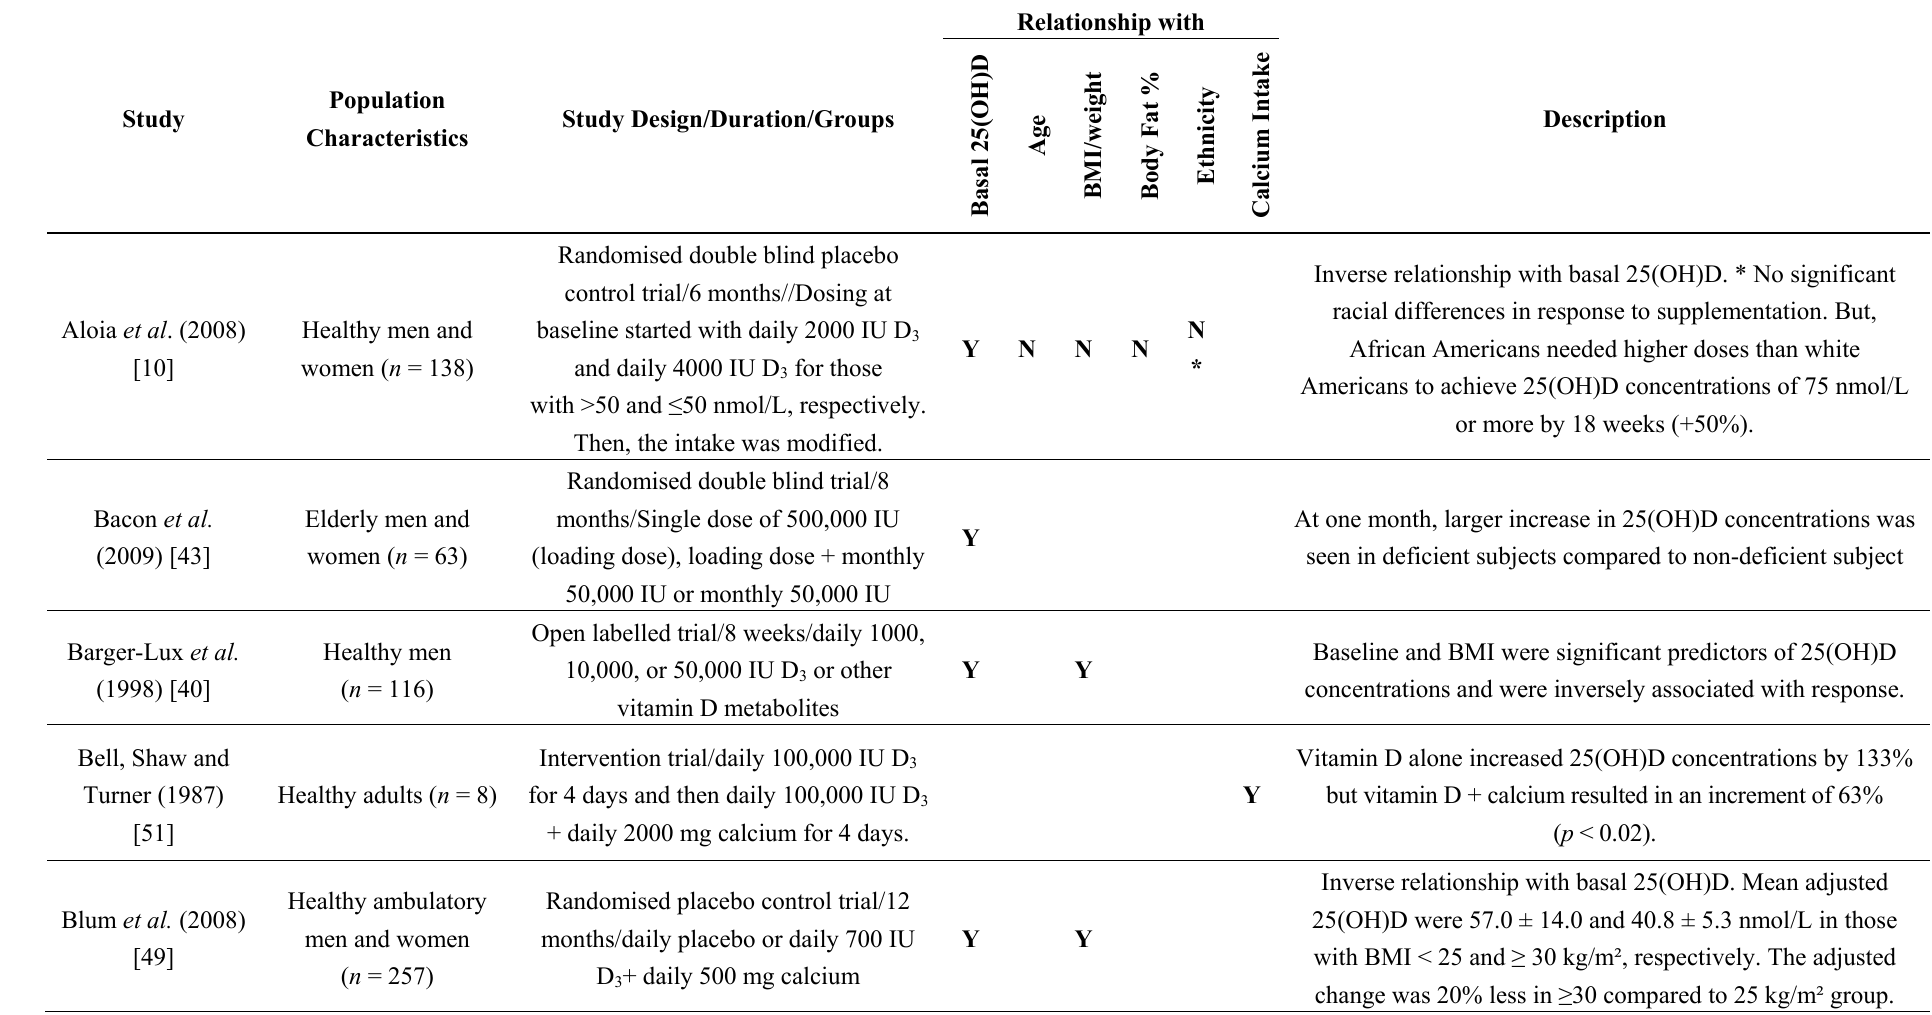
Table 1. Demographic and biological factors predicting circulating 25(OH)D response to vitamin D